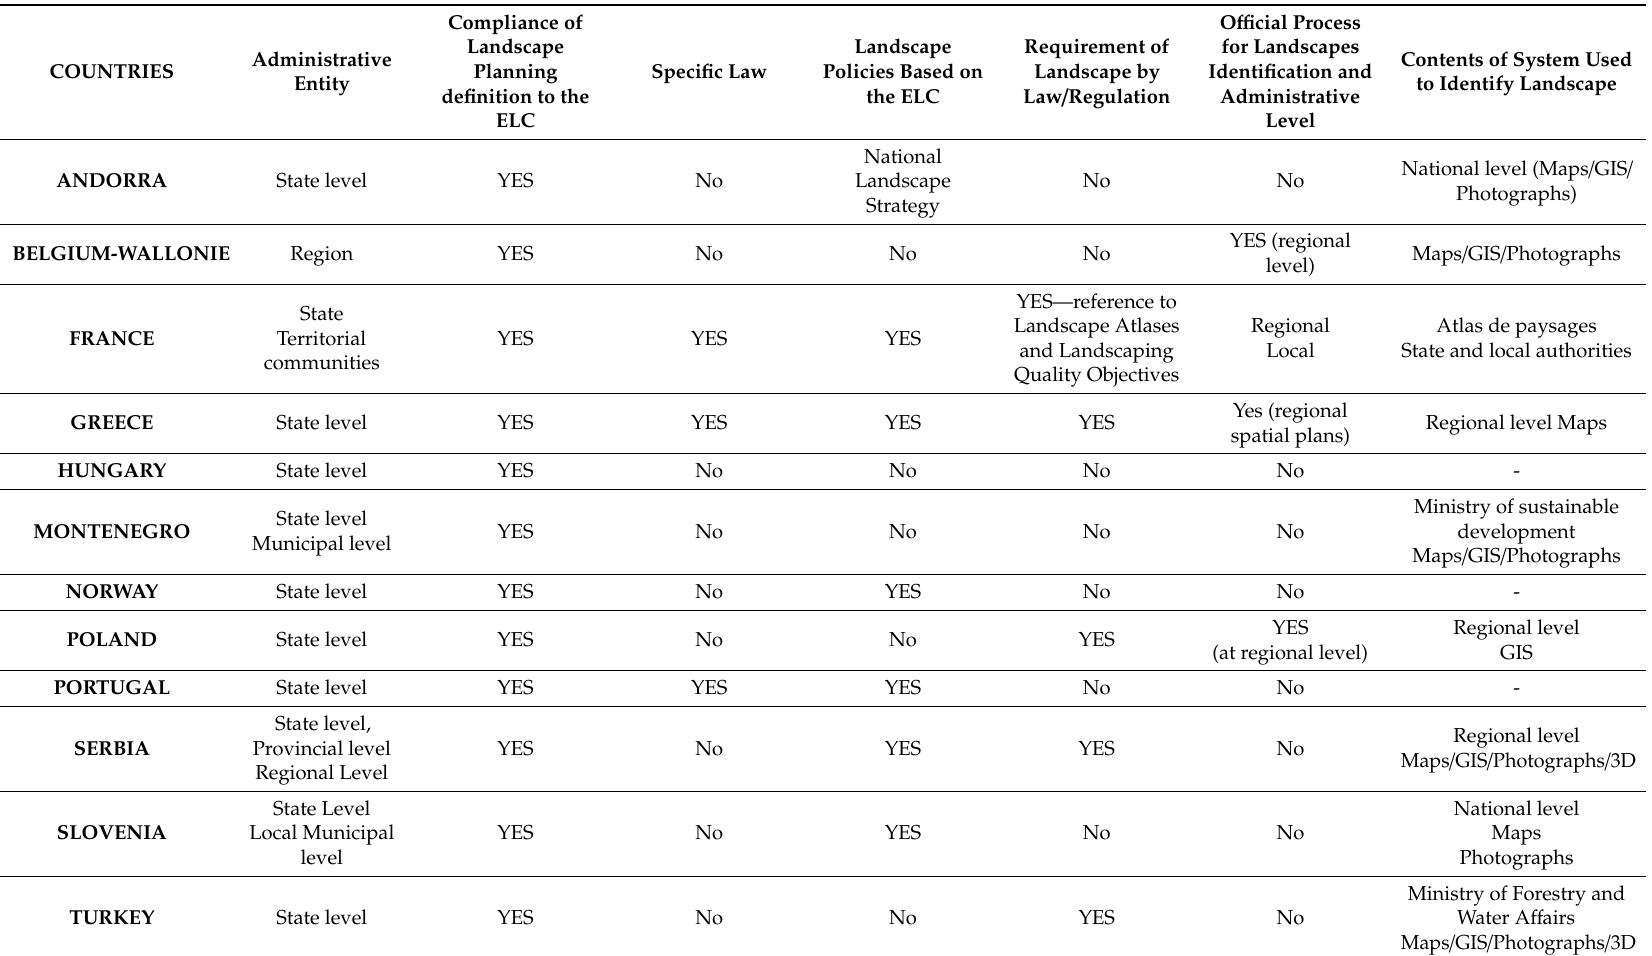
Table 2. Institutional recognition of Landscape and landscape planning, levels with landscape responsibilities and contents.